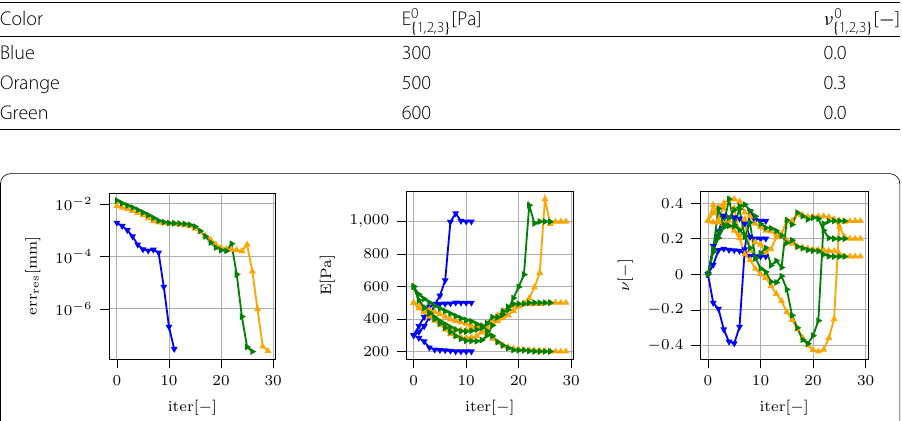
also expected from the algorithm as for every iteration a finite difference approximation of the partial derivatives in all parameters is used to find the next step. The great increase in convergence speed seen in Fig. 11a below err res = 10 − 4 mm is a hint, that a very local optimum is found, as also the parameters do not change much for those respective last